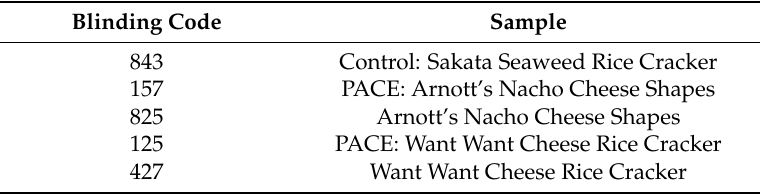
Table 2. Statements from the General Health Interest Scale [41].